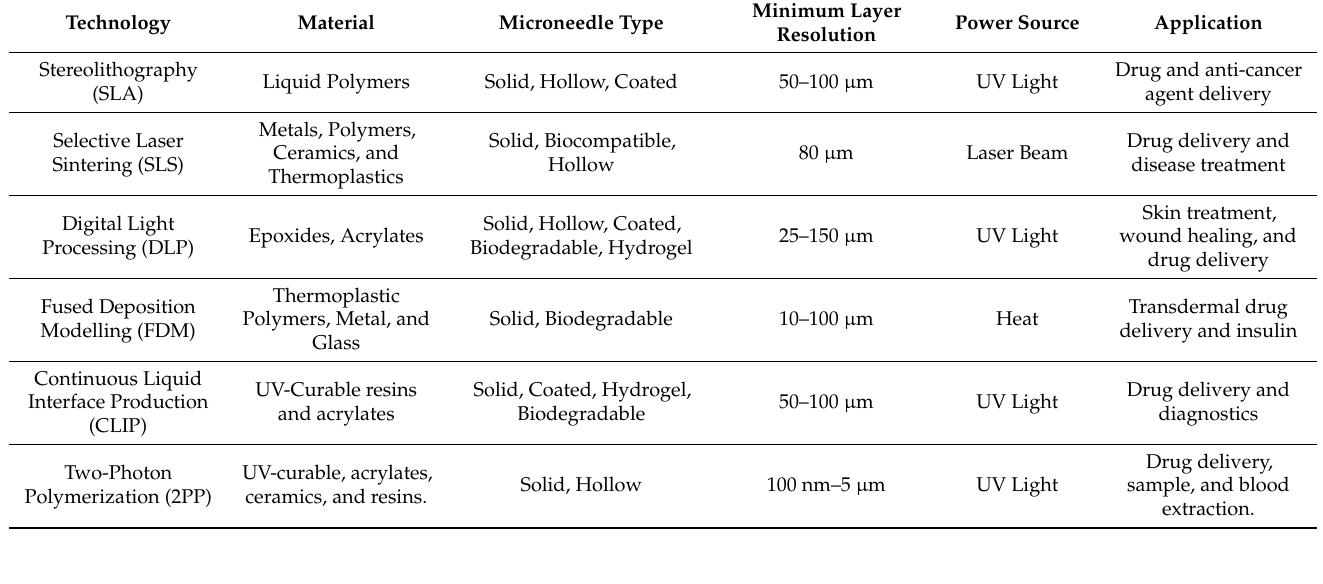
Table 4. Different 3D-printing technologies used for the fabrication of microneedles based on the microneedle type and application [115–117].